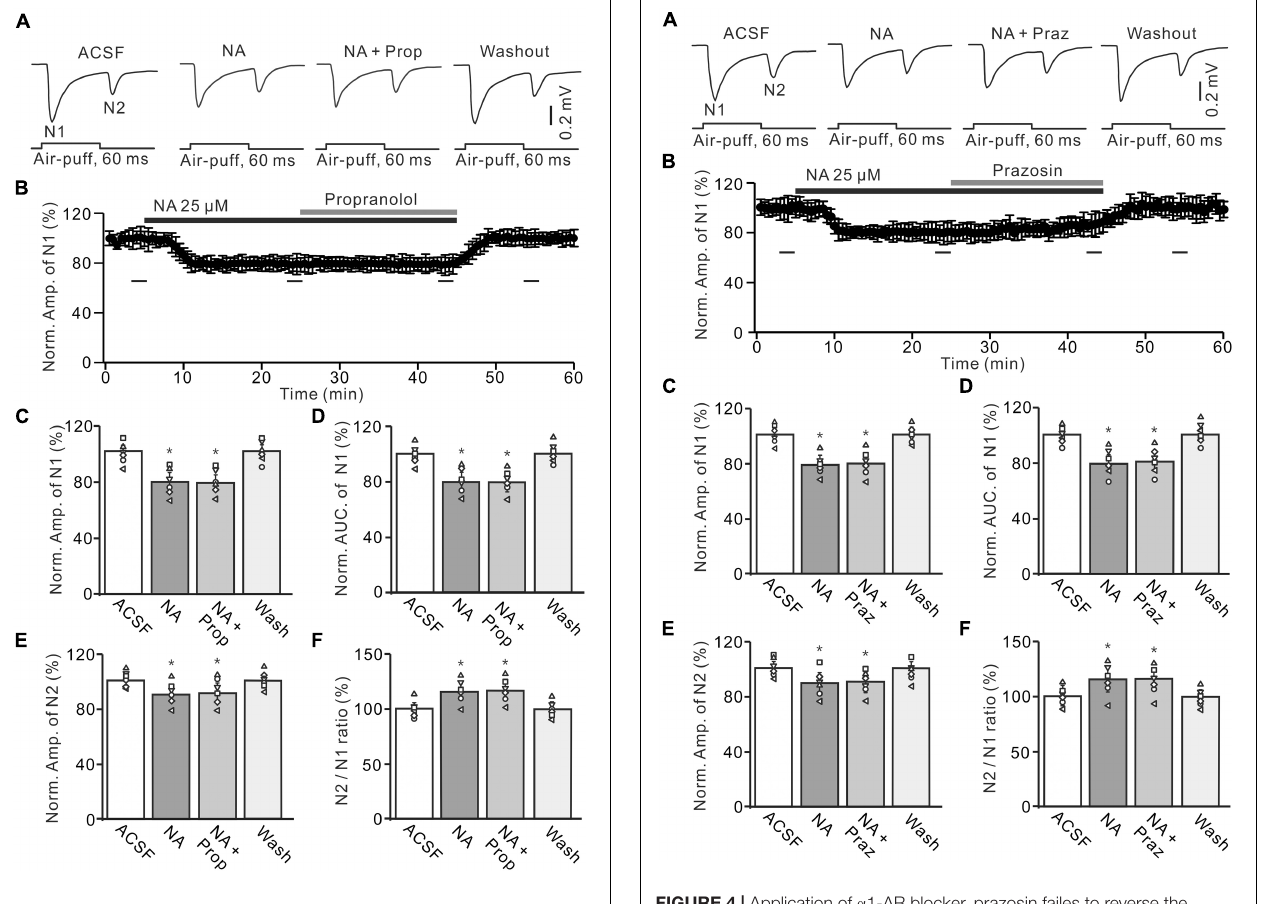
FIGURE 3 | Application of β -AR antagonist does less affect the NA-induced inhibition of the facial stimulation-evoked MF-GC synaptic transmission. (A) Representative field potential traces showing the facial stimulation (60 ms, 60 psi) evoked MF-GC synaptic transmission in a mouse cerebellar GL during treatment with ACSF, NA (25 µ M), NA + propranolol (Prop; 100 µ M), and recovery (washout). (B) Mean value ( ± SEM) with individual data showing the time course of normalized amplitude of N1 during treatment with ACSF, NA, NA + propranolol (Prop; 100 µ M) and recovery (washout). Bars denote the data points which were used in the bar graphs (C–F) in treatments with ACSF, NA, NA + propranolol and washout. (C,D) Mean value ( ± SEM) with individual data showing showing the normalized amplitude (C) and AUC (D) of N1 during each treatment. (E,F) Mean value ( ± SEM) with individual data showing the normalized amplitude of N2 (E) and the N2/N1 ratio (F) for each treatment. Note that propranolol failed to affect the NA induced inhibition of facial stimulation-evoked MF-GC synaptic transmission. * p < 0.05 versus control (ACSF); n = 6 in each group. on the NA-induced depression of MF-GC synaptic transmission.